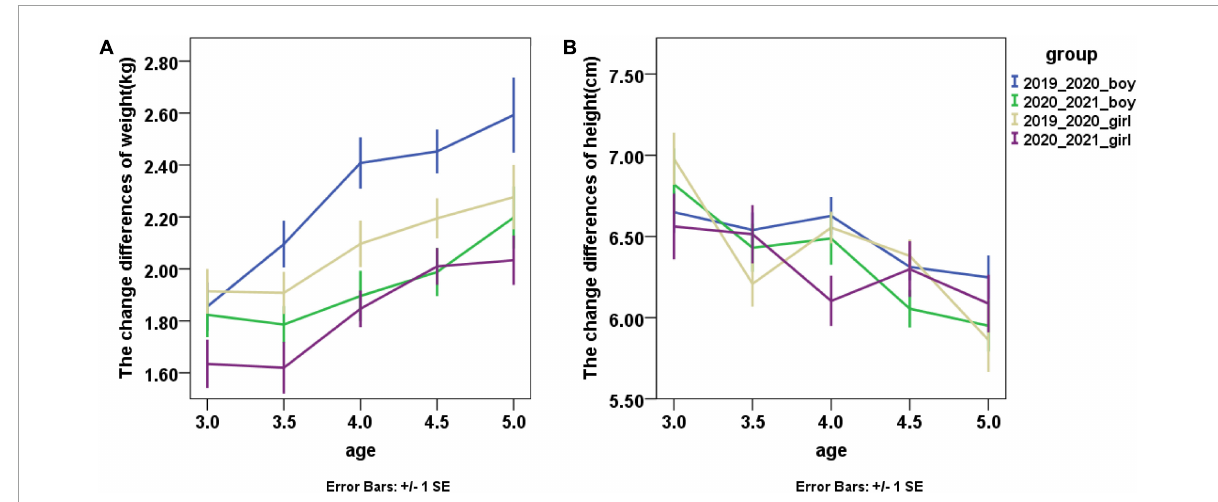
FIGURE1 The change differences of weight and height between 2020 and 2019 and between 2021 and 2020, (A) for weight; (B) for height.